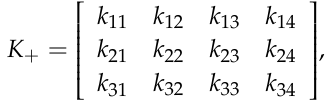
rotating clockwise) with modified observer gains. modified observer